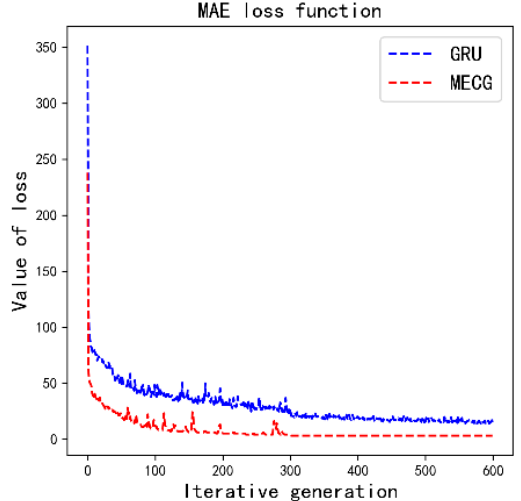
Figure 14. The convergence rate of GUR and MECG models.